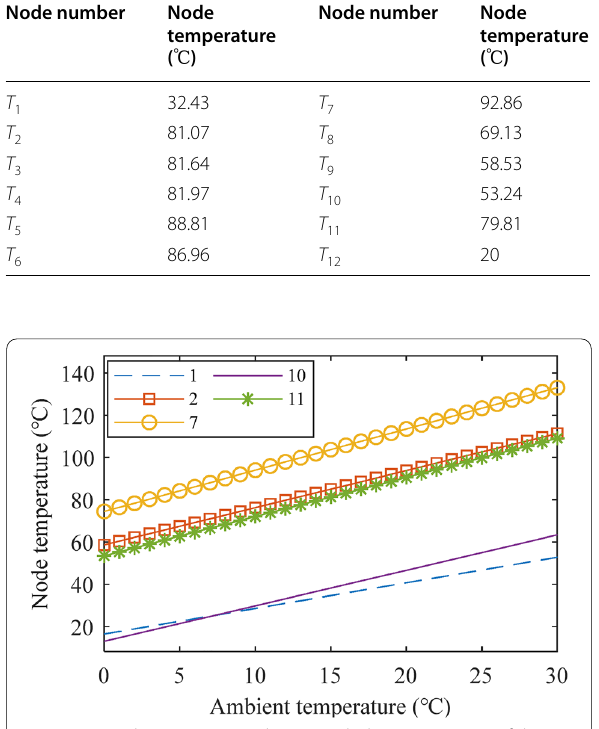
Figure 7 Node temperature change with the temperature of the air around axle box